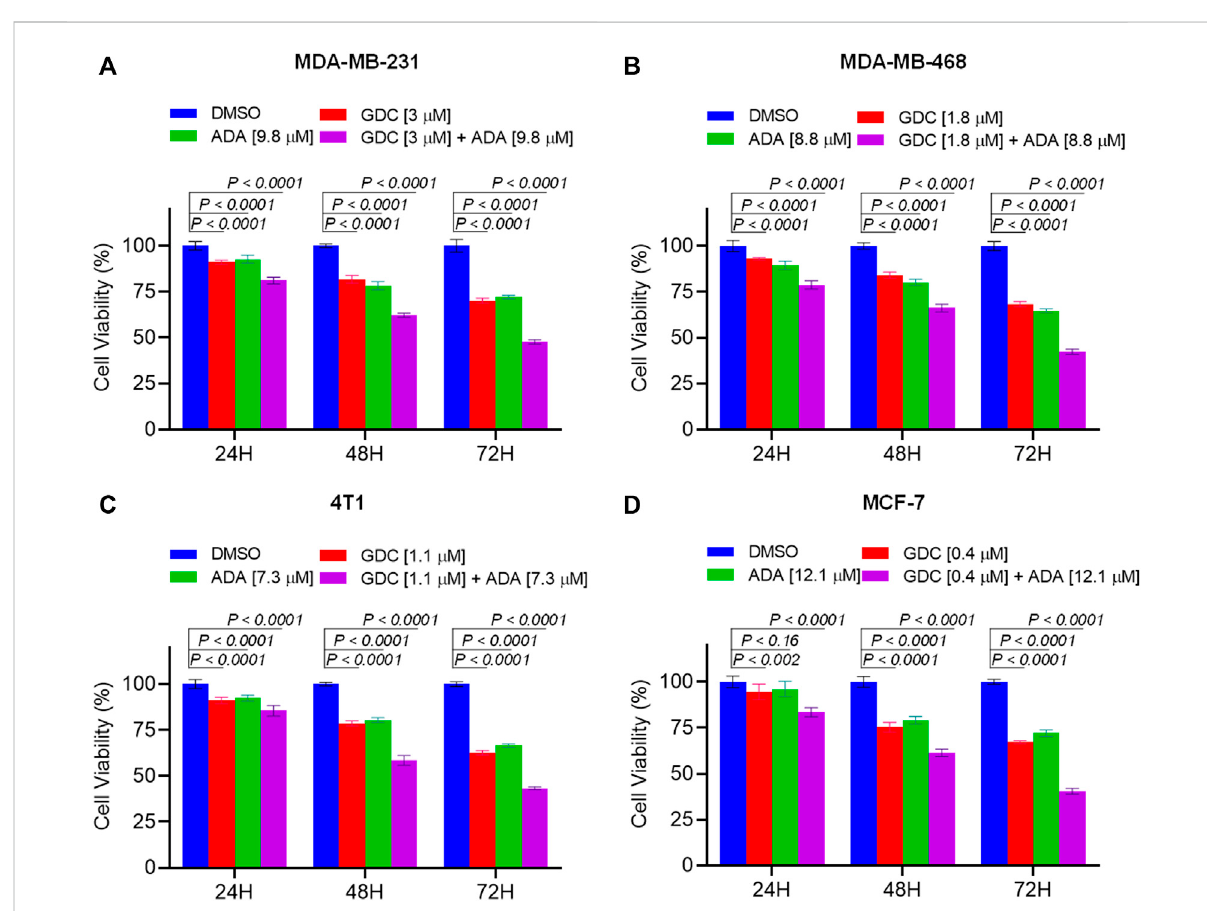
FIGURE 3 Combination of GDC-0941 and adapalene reduces tumor cell proliferation. The combination of GDC and ADA inhibited proliferation of (A) . MDA-MB-231 (B) . MDA-MB-468 (C) . 4T1 (D) . MCF-7 in a synergistic manner. Data are mean ± SD. p -values were determined by two-way ANOVA followed by Tukey ’ s multiple comparisons test. Signi fi cant reduction in cell viability was observed when treated in a time-dependent manner with combined treatment of GDC and ADA showing a maximal